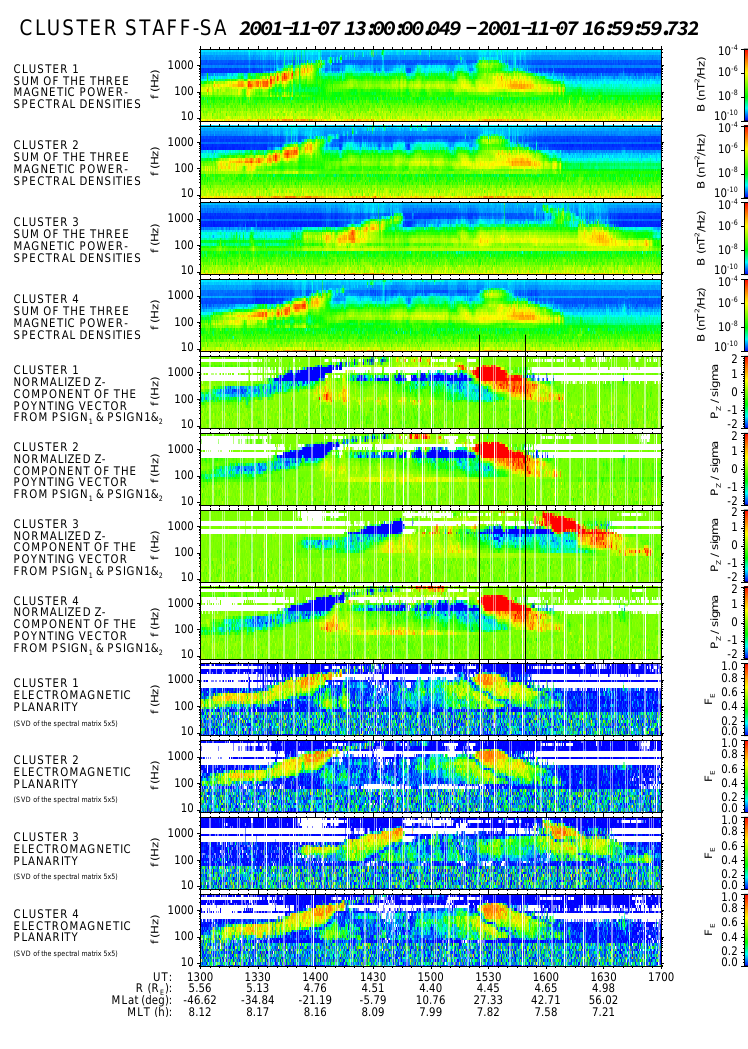
Fig. 6. Same as Fig. 1 but for the chorus event recorded on 7 November 2001 between 13:00 and 17:00UT.